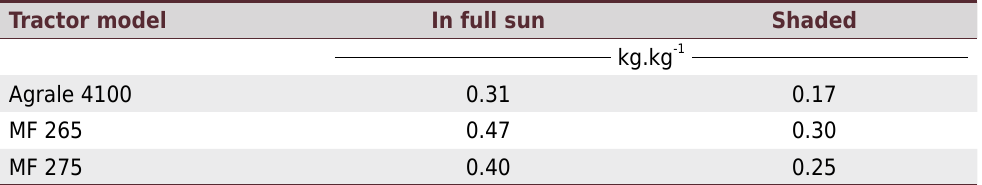
Table 4. Values of critical soil water content for the traffic of agricultural tractors in coffee plantations managed in full sun and shaded Tractor